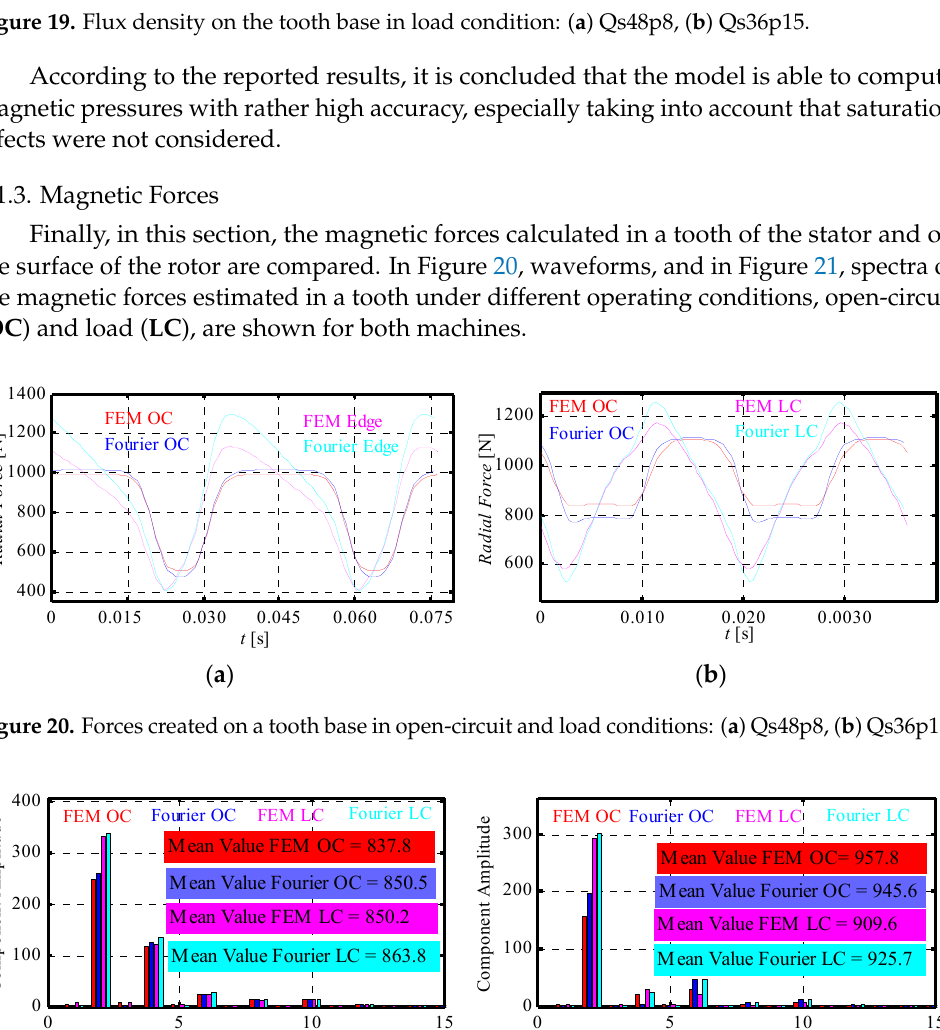
Figure 19. Flux density on the tooth base in load condition: ( a ) Qs48p8, ( b ) Qs36p15.